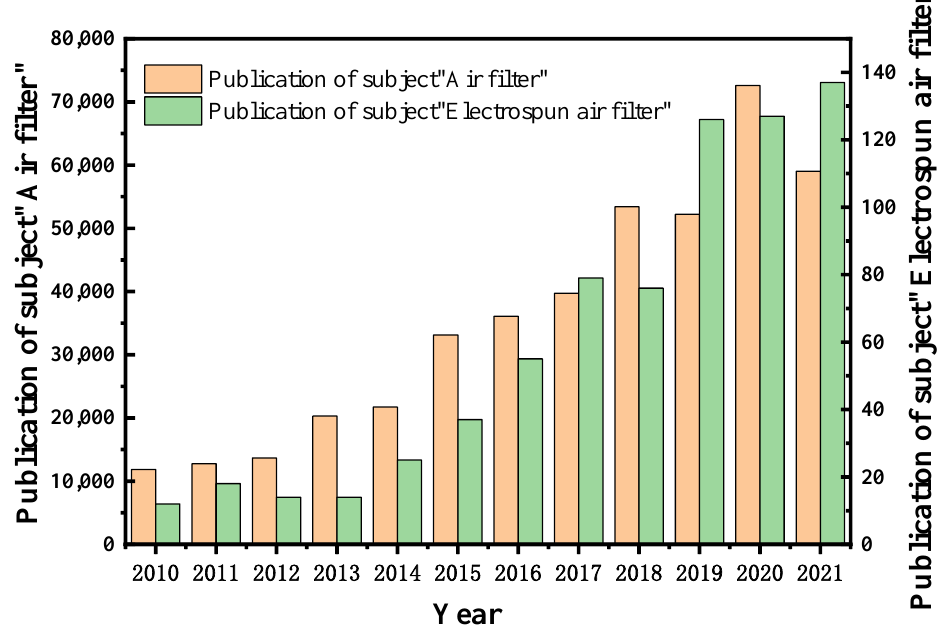
Figure 1. Literature search statistics using the themes “air filter” and “electric spinning and electro- spinning air filter” on the “Web of Science” platform .